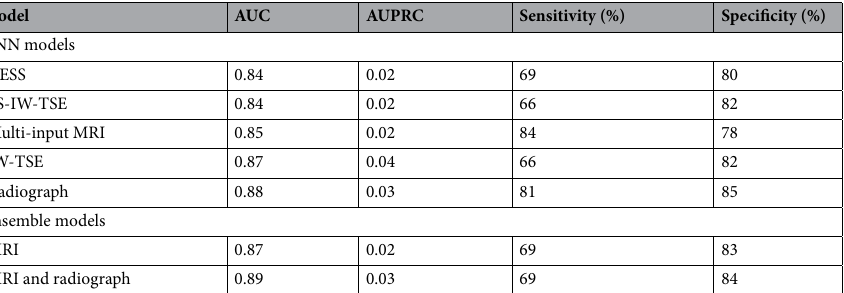
TKR had regions of high activation on the peripheral bone-cartilage interfaces of the medial and lateral femoral condyles and tibia plateau, intercondylar notch, and medial meniscus compared to subjects without TKR. Signifi- cantly higher proportion ( p < 0.05) of control subjects without TKR had regions of high activation on the central bone-cartilage interfaces of the femoral condyles and tibia plateau compared to subjects with TKR (Figs. 3, 4).